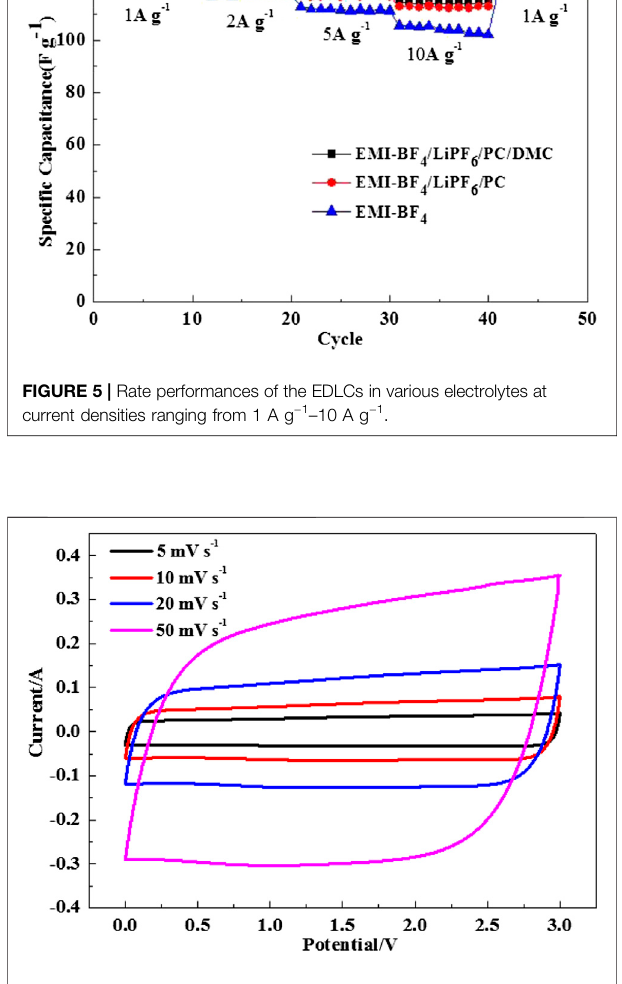
FIGURE 6 | CV curves of the EDLC in EMI-BF 4 /LiPF 6 /PC/DMC at varied scan rates.